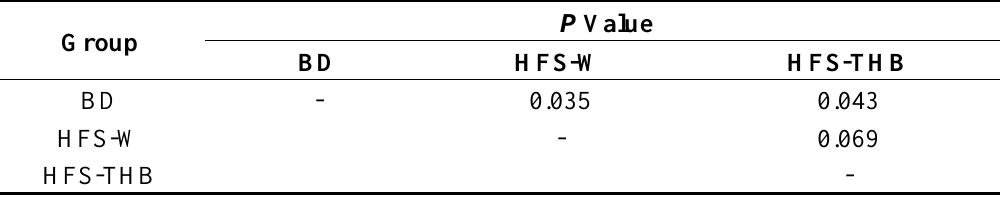
Samples were analyzed using linear regression